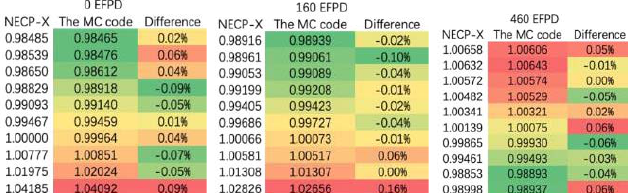
Figure 12. The plate power and its difference for JRR-3M standard fuel assembly (1/4) with burnup